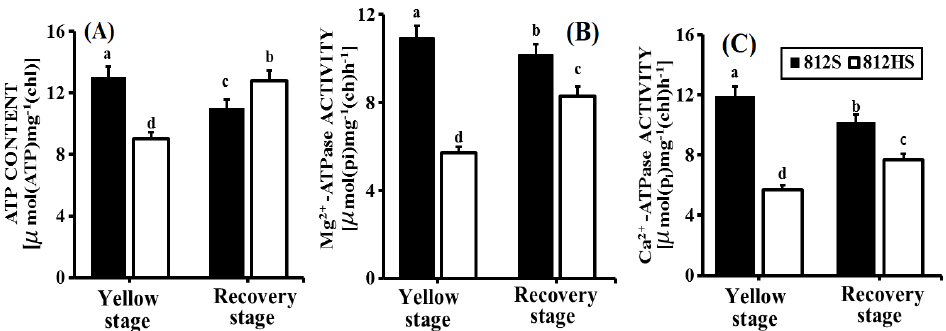
Figure 6. Effects of photooxidation on ATP content ( A ), Ca 2+ -ATPase activity ( B ), and Mg 2+ -ATPase activity ( C ) in leaves of 812HS and 812S. Data are mean ± SD ( n = 3). Different letters indicate significant variation ( p < 0.05).